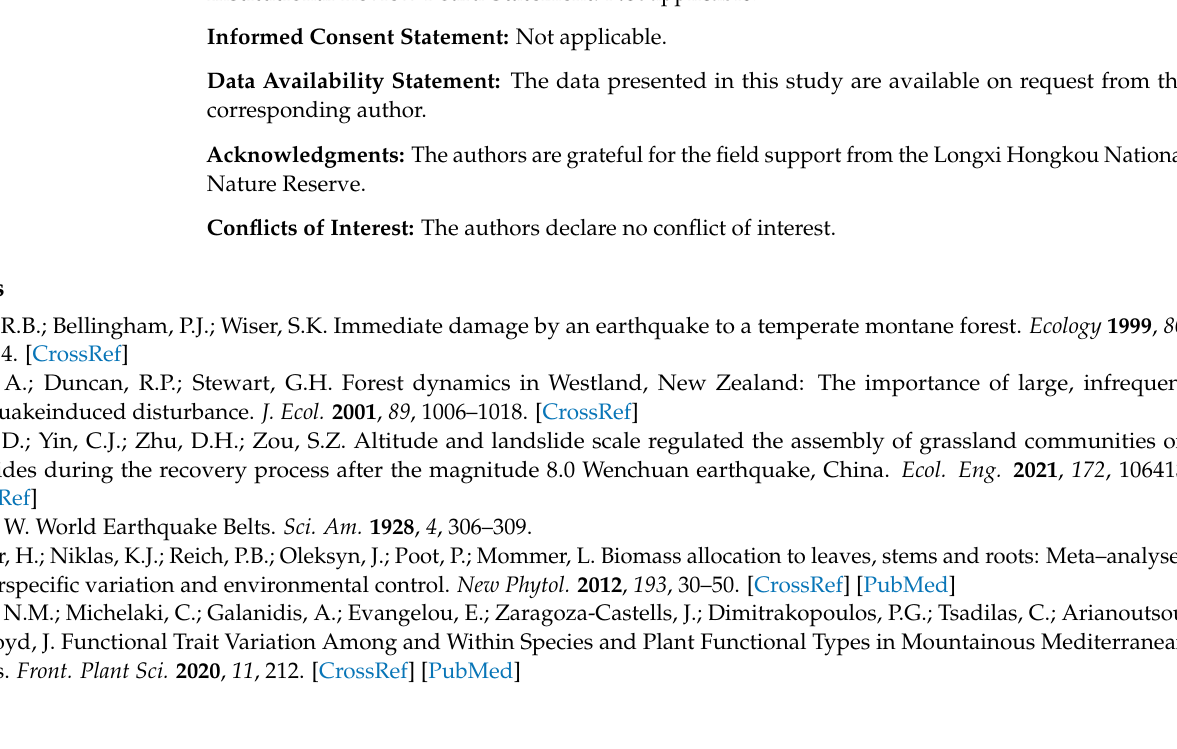
Figure S3: Key species of difference in functional traits between landslide and not-landslide; Table S1: Mean monthly averages of climate data for the last 50 years; Table S2: Details of sampling sites; Table S3: Abbreviations of this study; Table S4: One-way variance analysis of woody plant functional traits between WFTs on landslide and